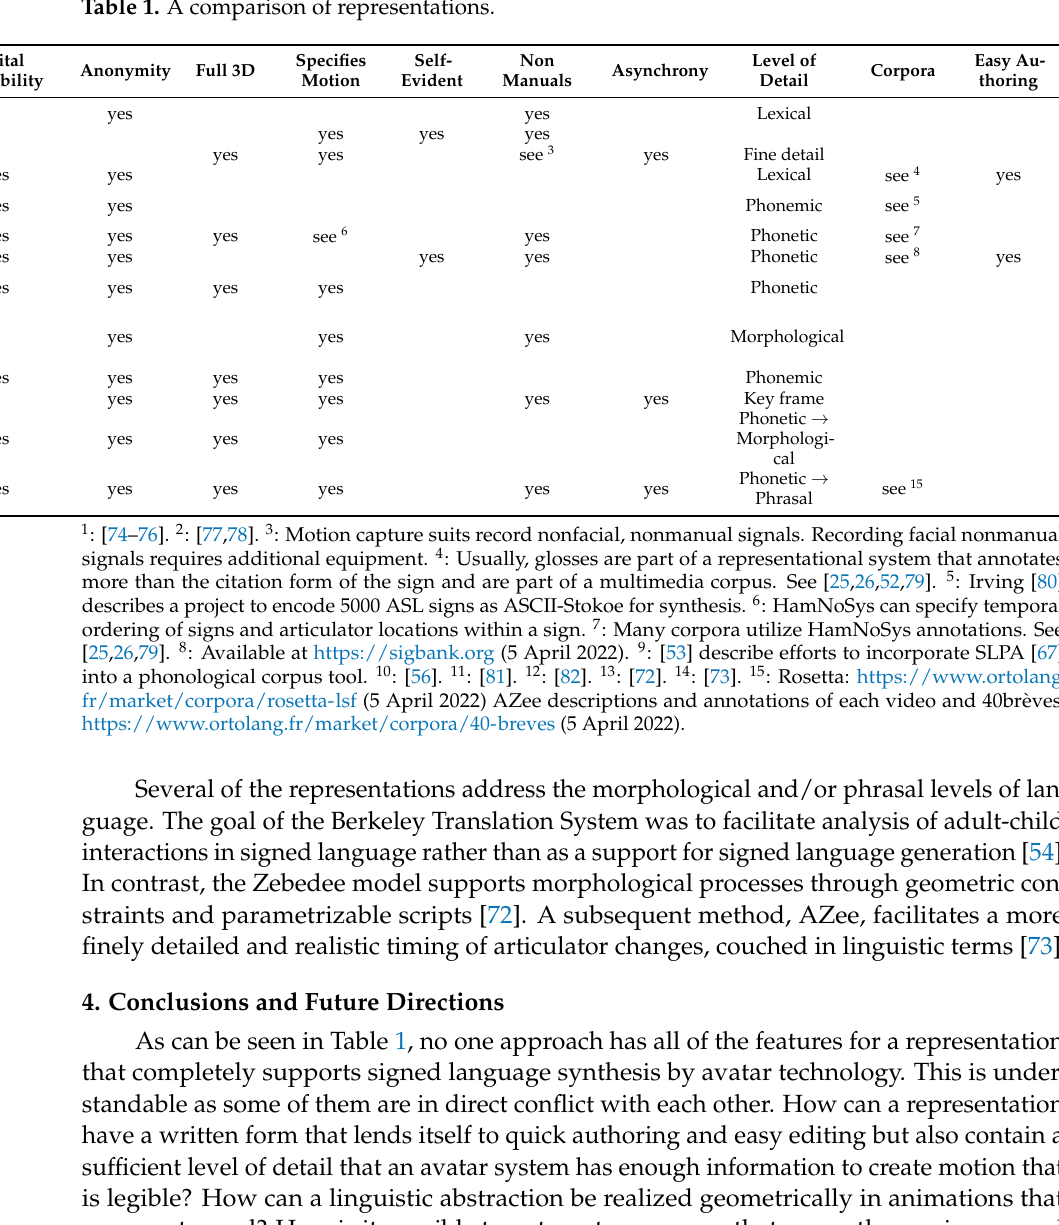
Table 1. A comparison of